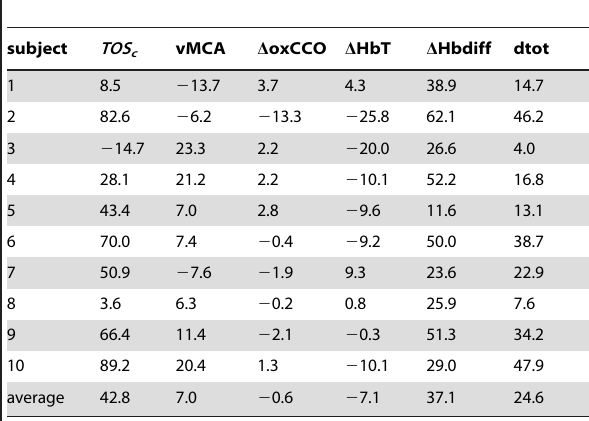
Table 5. The prediction factors P ( : , : ) for each subject and each signal following Fit